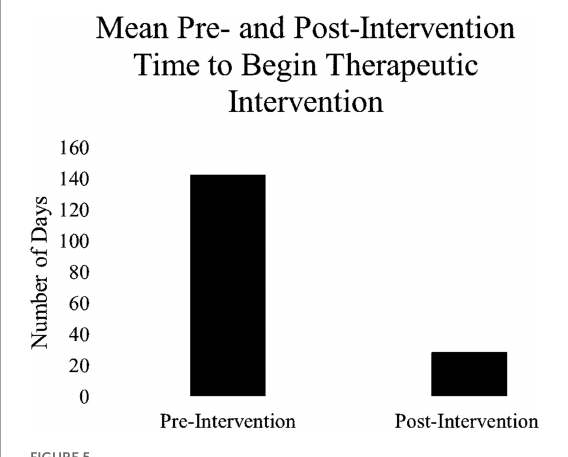
FIGURE5 Average number of days waited before beginning therapeutic intervention.